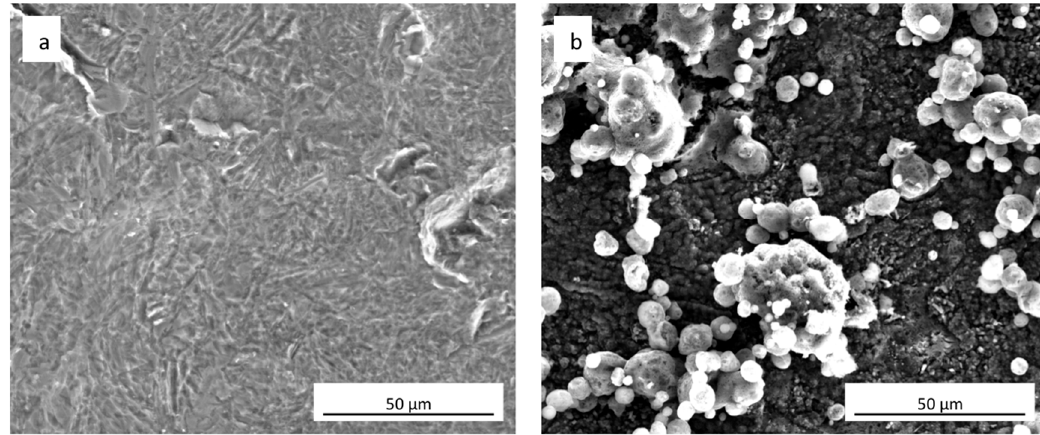
Figure 1. Surface morphology (SEM-FEG) of ( a ) as-received uncoated cpTi and ( b ) sphene-coated cpTi.